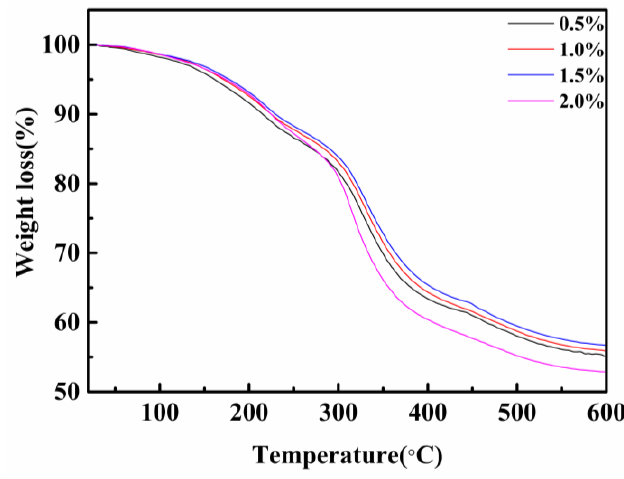
Figure 9. Thermogravimetric diagram of different crosslinker contents.